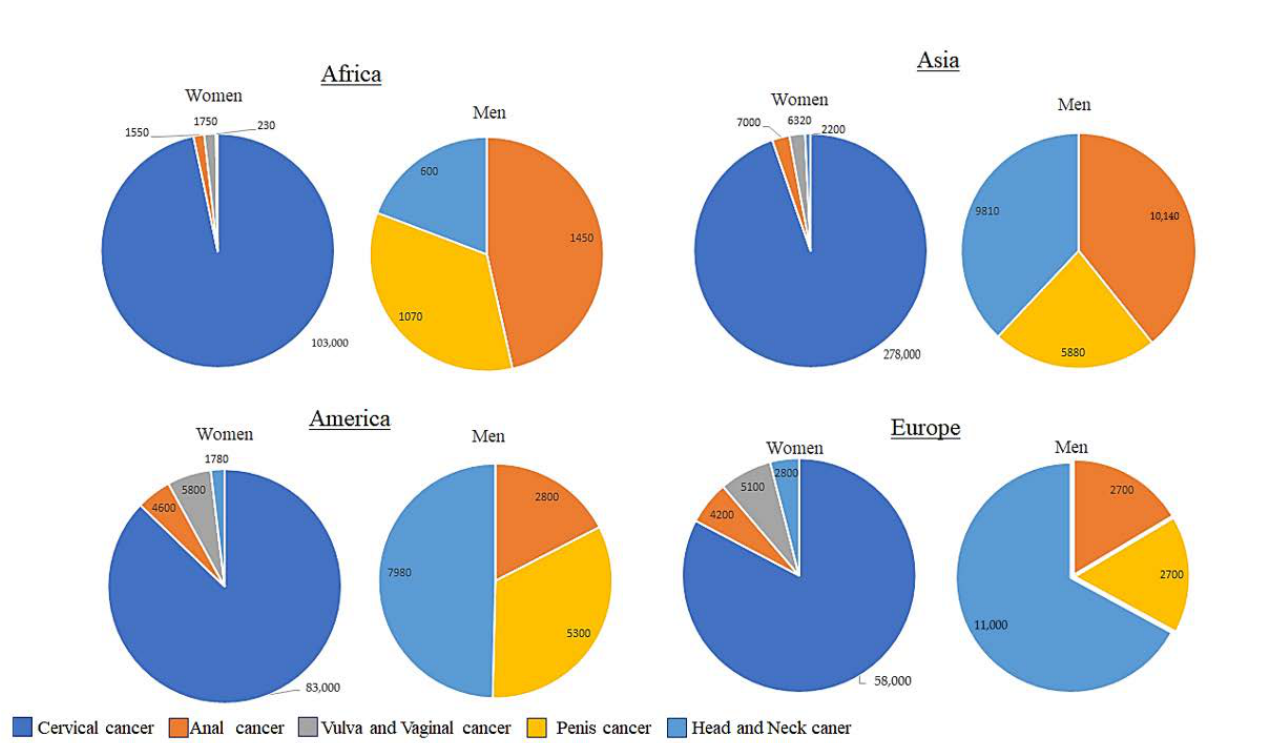
Figure 3. HPV-related cancers in Africa, Asia, America and Europe. Regardless of the continent, cervical cancer is the most common HPV-associated cancer in women. Amongst men, Africa is different from America, Asia and Europe as anal cancer is the most common HPV-related cancer in Africa. In Asia, head and neck cancer and anal cancer are the most common HPV-related cancers. In America and Europe, the most common HPV-related cancer is head and neck